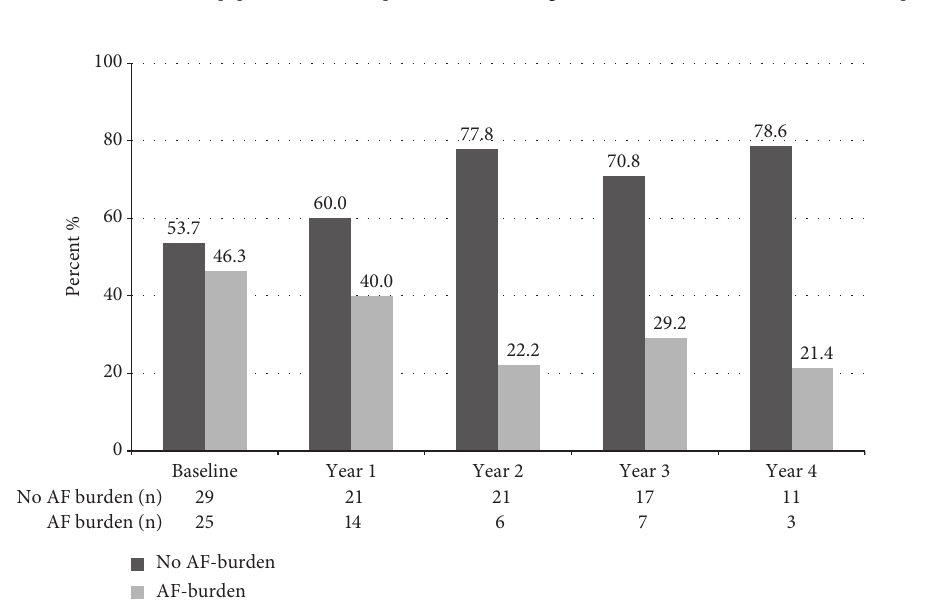
Figure 1: Participants stratified by the presence or absence of atrial fibrillation (AF) over all study